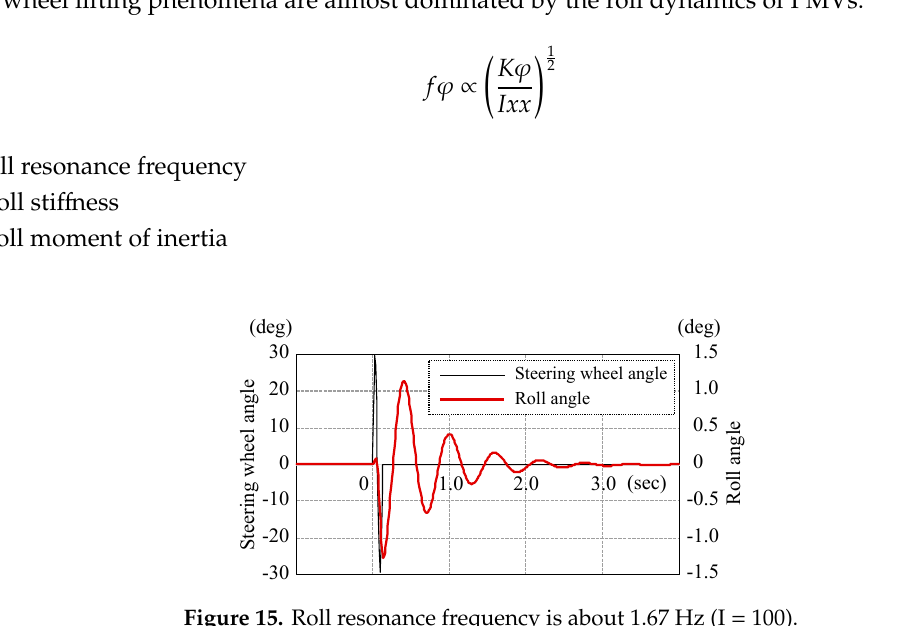
Figure 15. Roll resonance frequency is about 1.67 Hz (I = 100).